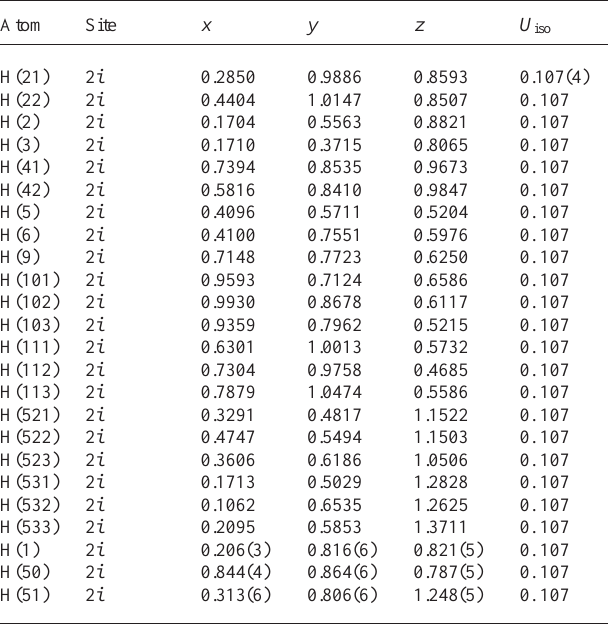
Table 2. Atomic coordinates and displacement parameters (in Å 2 ) .